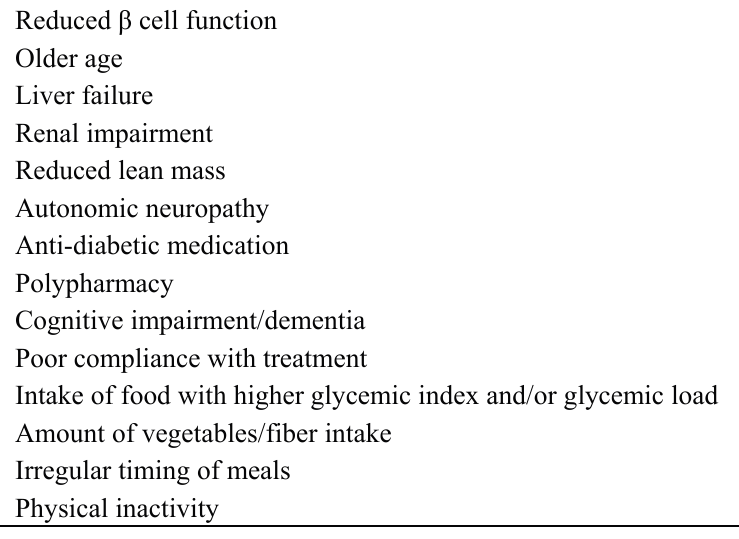
Table 2. Factors associated with greater glycemic